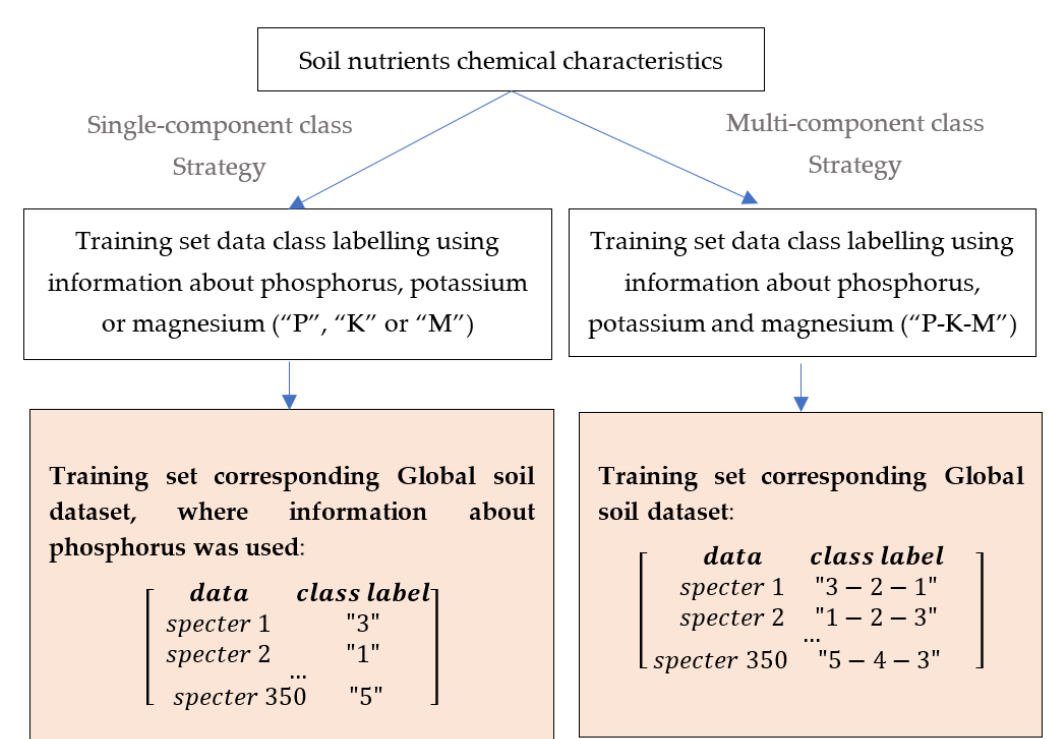
Figure 2. Flow diagram of the Training set class labelling using single-component (left) and multi-component (right) strategy, corresponding Category II. Table 6. Results of the soil properties prediction using a single and multi-component class strat- egy.